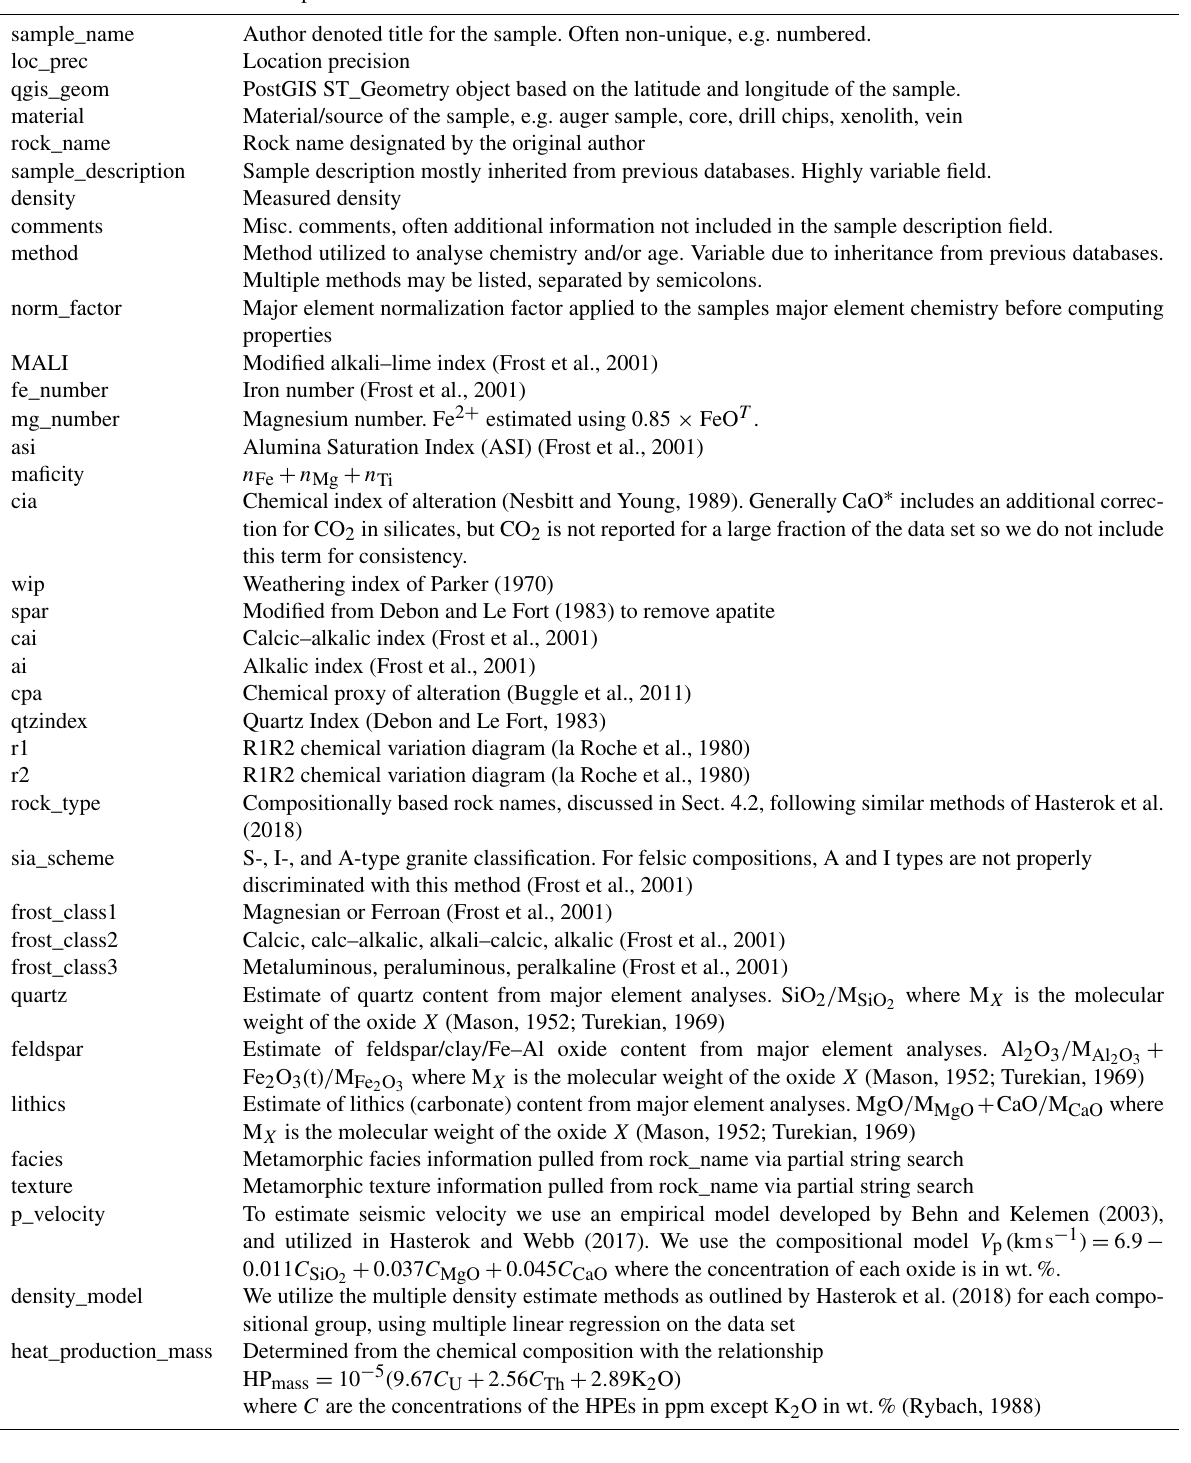
Table 3. Potentially ambiguous column